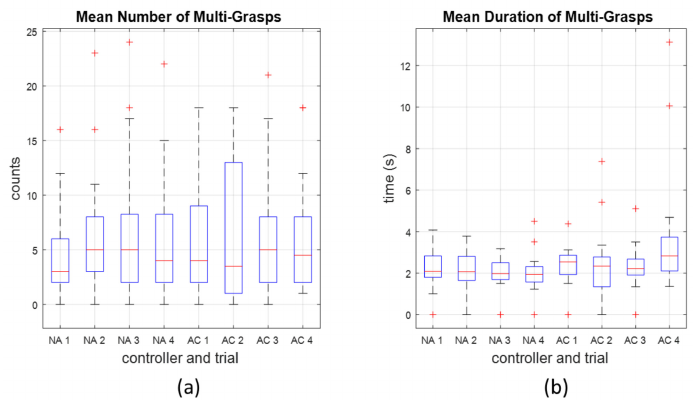
Figure 8. Number ( a ) and duration ( b ) of multi-grasps in the trials using NA and AC controllers. Extreme outliers in terms of duration occurred for two subjects during the fourth trial of the AC